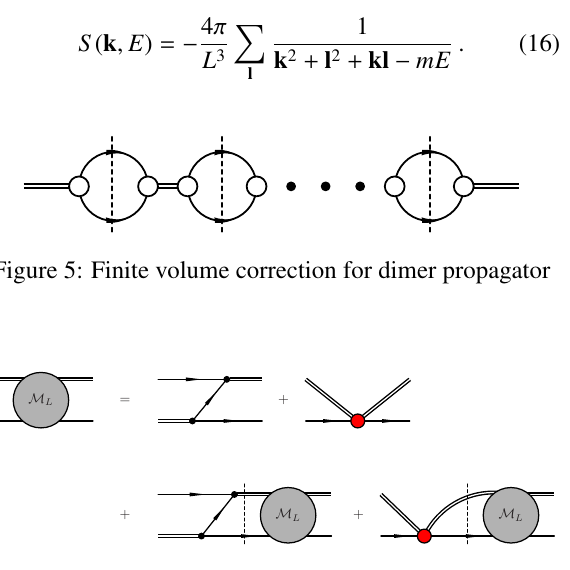
Figure 6: Finite volume scattering equation